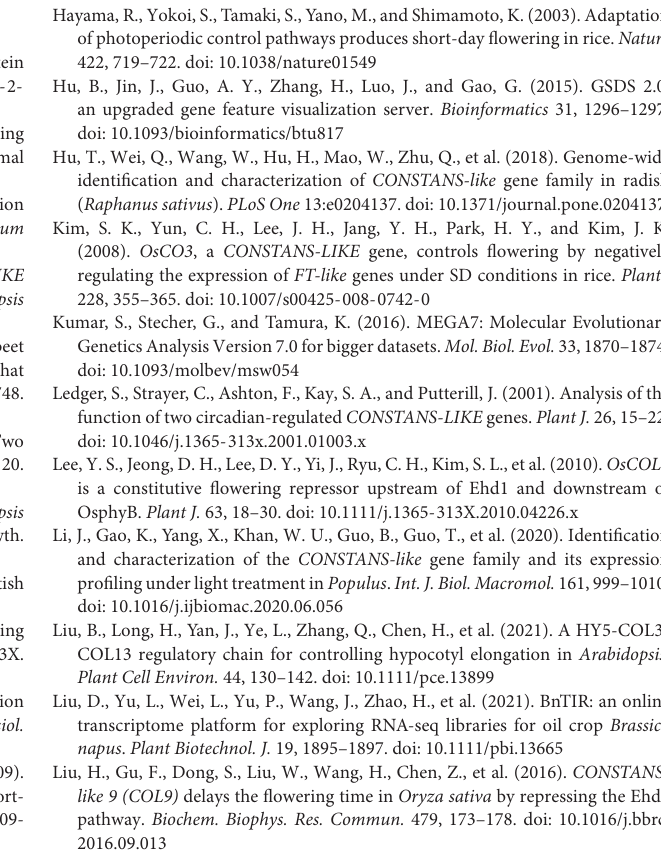
Supplementary Figure 1 | Multiple sequence alignment of AtCOL and BnaCOL proteins. Supplementary Figure 2 | Three-dimensional structure prediction of B-box domain of BnaCOL proteins. (A) Two B-box domains from group I. (B) A B-box domain and a second divergent B-box domain from group II. (C) One B-box domain from group III. The images are from dark blue to dark red, indicating from the N end to the C end. Supplementary Figure 3 | GO annotation of BnaCOL genes in B. napus